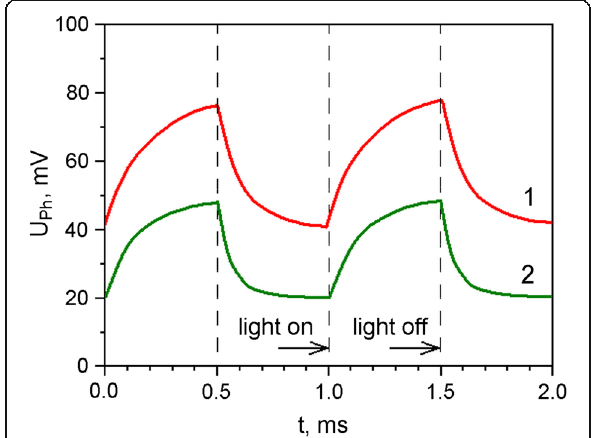
Fig. 6 Kinetics of the photoresponse to rectangular 940 nm (curve 1 ) and 570 nm (curve 2 ) light pulses for PS – RGO structure